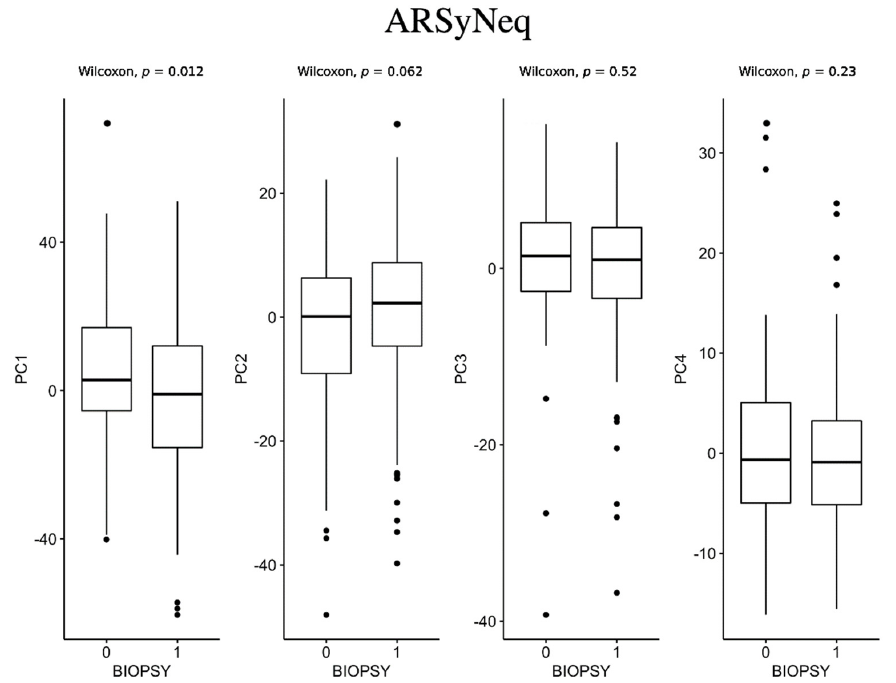
Figure 5. Box plots for ARSyNseq method between negative biopsy (class 0) and positive biopsy (class